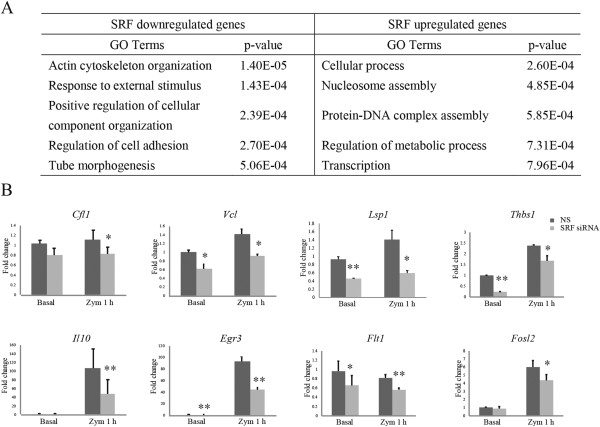
SRF is required for macrophage function in response to zymosan stimulation. (A) Gene ontology analysis for biological process annotations of downregulated and upregulated SRF dependent genes after zymosan treatment for 1 h. (B) mRNA expression profiles of the indicated representative SRF dependent genes were analyzed by Q-PCR. Thioglycollate-elicited macrophages were transfected with nonspecific (NS) or specific siRNAs for SRF and treated with or without zymosan for 1 h. **p < 0.01 vs. NS; *p < 0.05 vs. NS. Target gene expression is represented as the average fold change compared to NS siRNA transfected samples of at least three independent experiments. Error bars represent standard deviations.